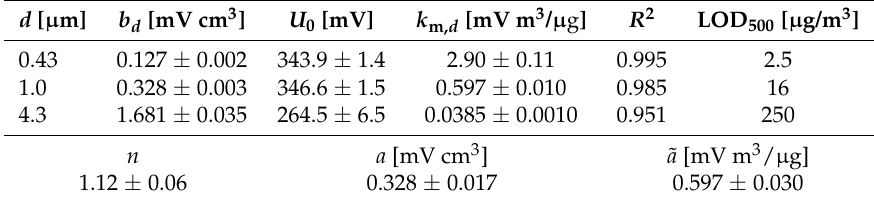
Table 2. Parameters to describe the data in Figure 8.